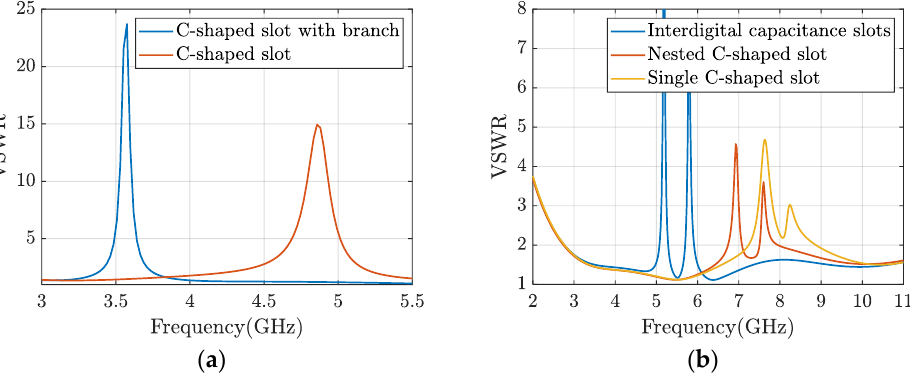
Figure 9. Simulated VSWR of the proposed antenna under different structures. ( a ) Curled C-shaped slots. ( b ) Interdigital inductance slot.